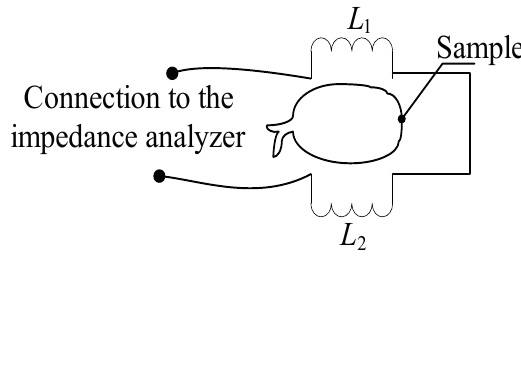
Figure 4. Electrical diagram for the dual flat type shape air